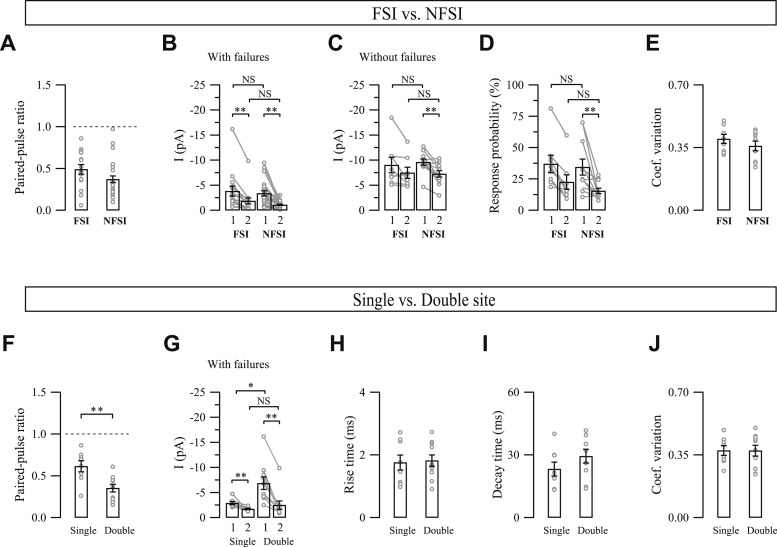
Properties of unitary synaptic interneuron-NG2 cell connections.(A–E) Comparison of synaptic properties between FSI-NG2 cell and NFSI-NG2 cell connections. Note that no differences exist between these two types of connections though some differences exist when comparing PSC1 (1) and PSC2 (2) within each type of connection. (F–J) Comparison of synaptic properties between connections showing single- and double-vesicular release sites. Note that the PPR (F) and mean amplitudes with failures (G) of PSC1 (1) and PSC2 (2) were different between these two types of connections, whereas rise (H) and decay (I) times and the coefficient of variation (J) were similar. NS: not significant; *p < 0.05, **p < 0.001. For readability, NS tests were indicated only in panels B–D and G.